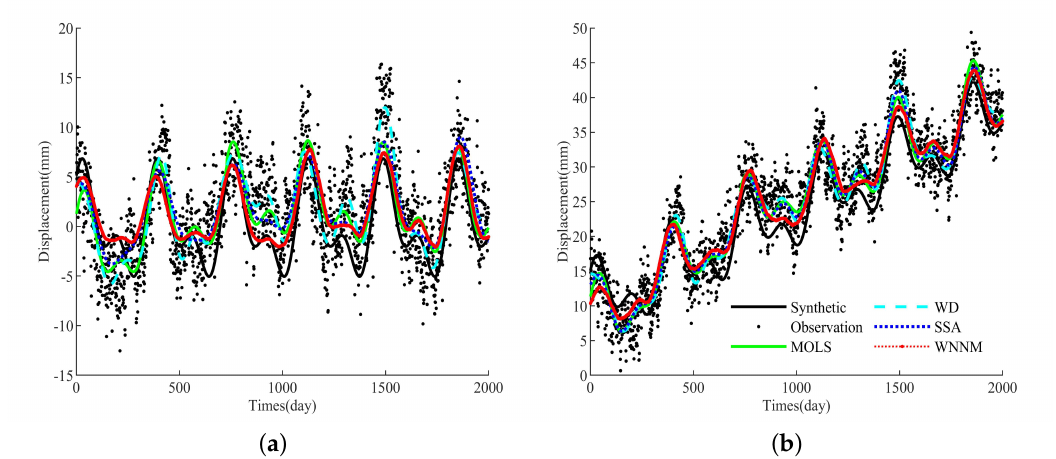
Figure 3. Comparison between extracted signal and original GNSS time series, where σ f = 10mm/yr − k 4 . Black scatter shows GNSS observed time series, black solid line represents the simulated GNSS time series and green, cyan, blue and red lines represent signals extracted by applying MOLS, WD, SSA and WNNM, respectively. ( a ) Without trend and ( b ) with a linear trend.